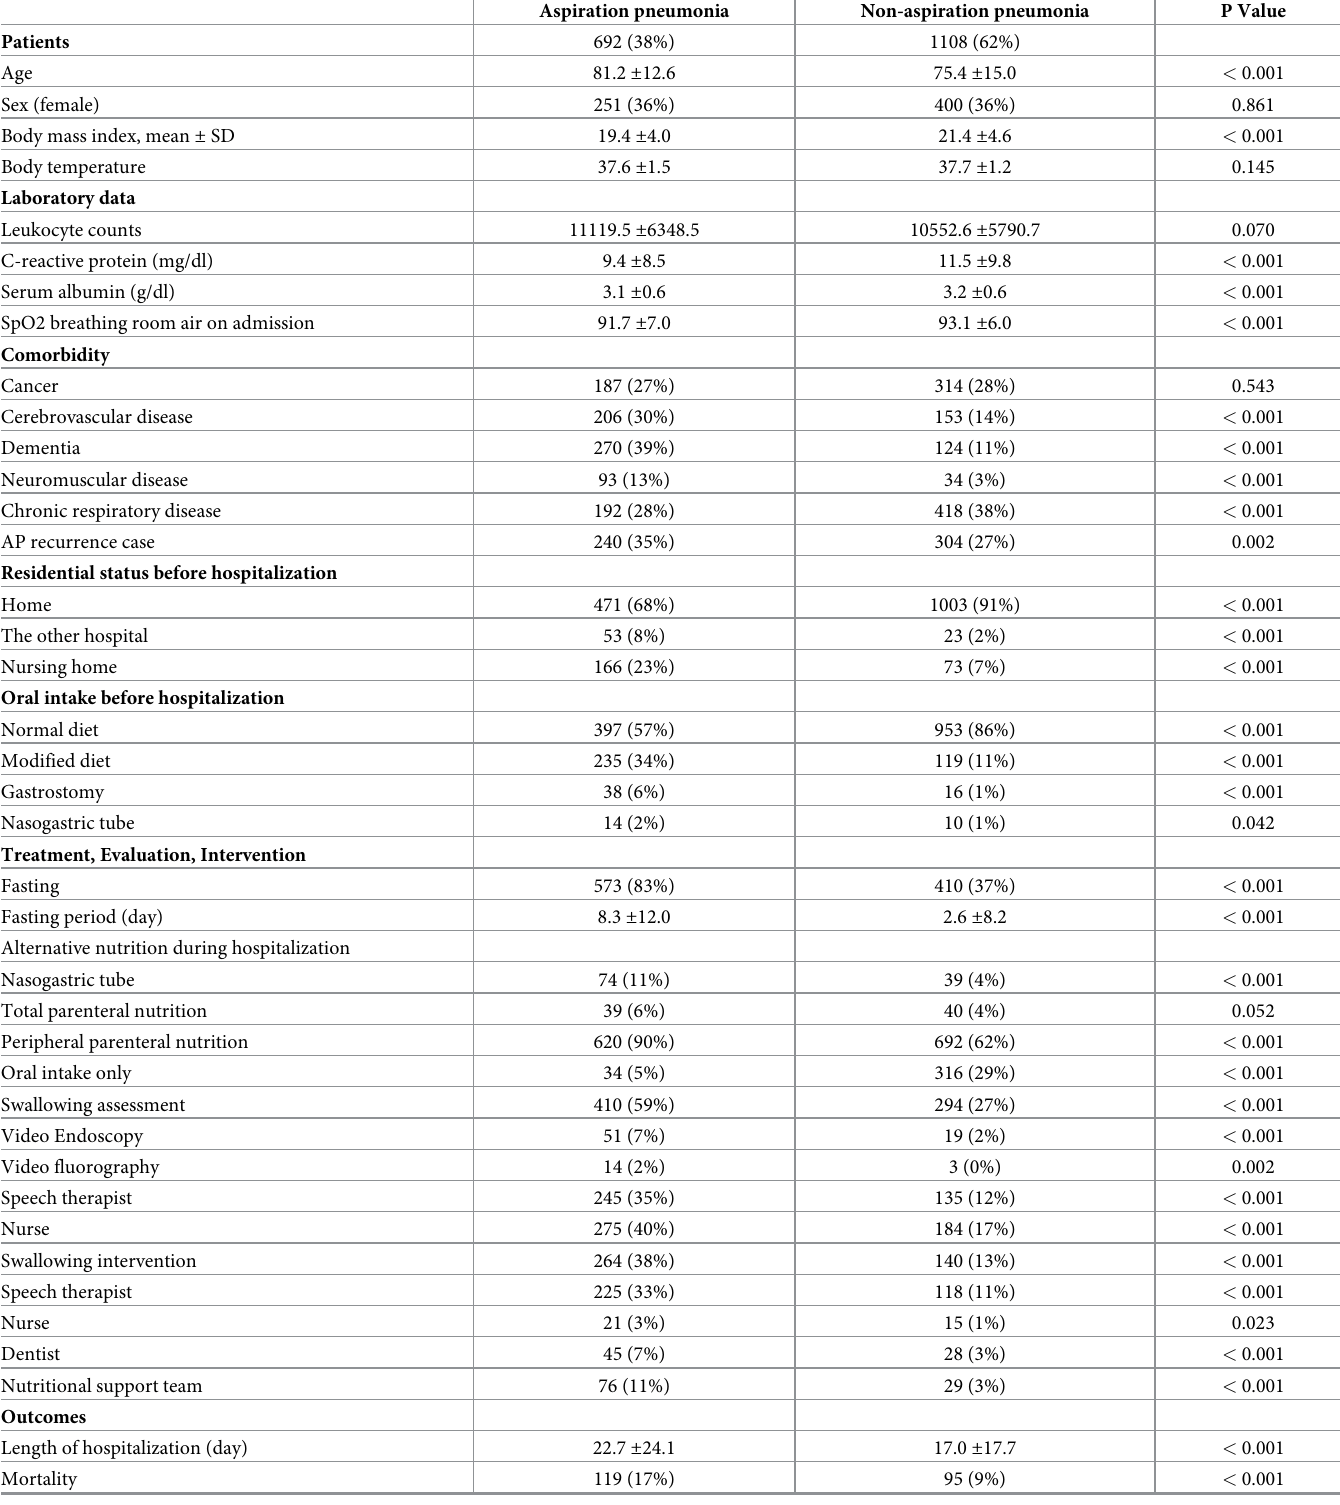
Table 1. Characteristics of patients with aspiration and non-aspiration